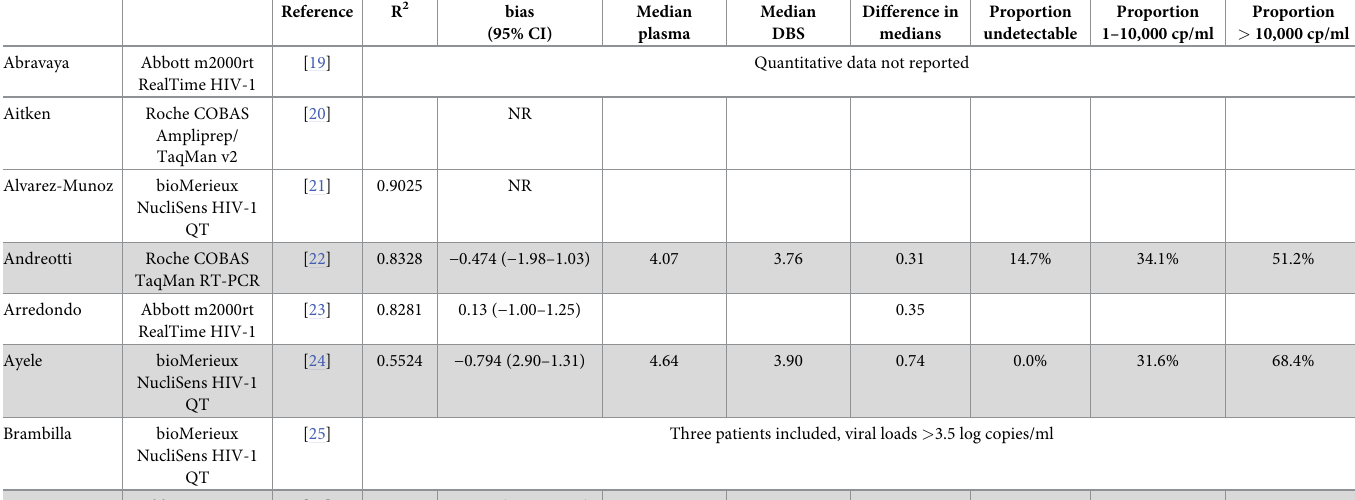
Table 2. Analytical and clinical metrics for each study.